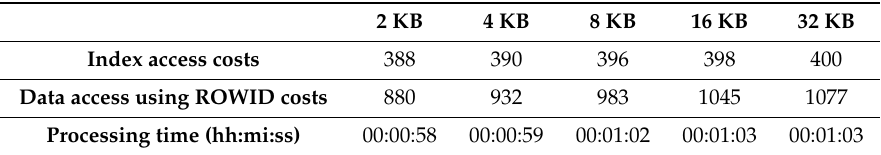
Table 5. Data block size and performance impacts.